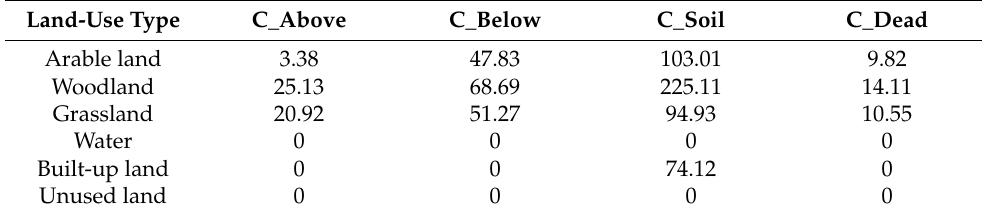
Table 5. The carbon density for each land-use type